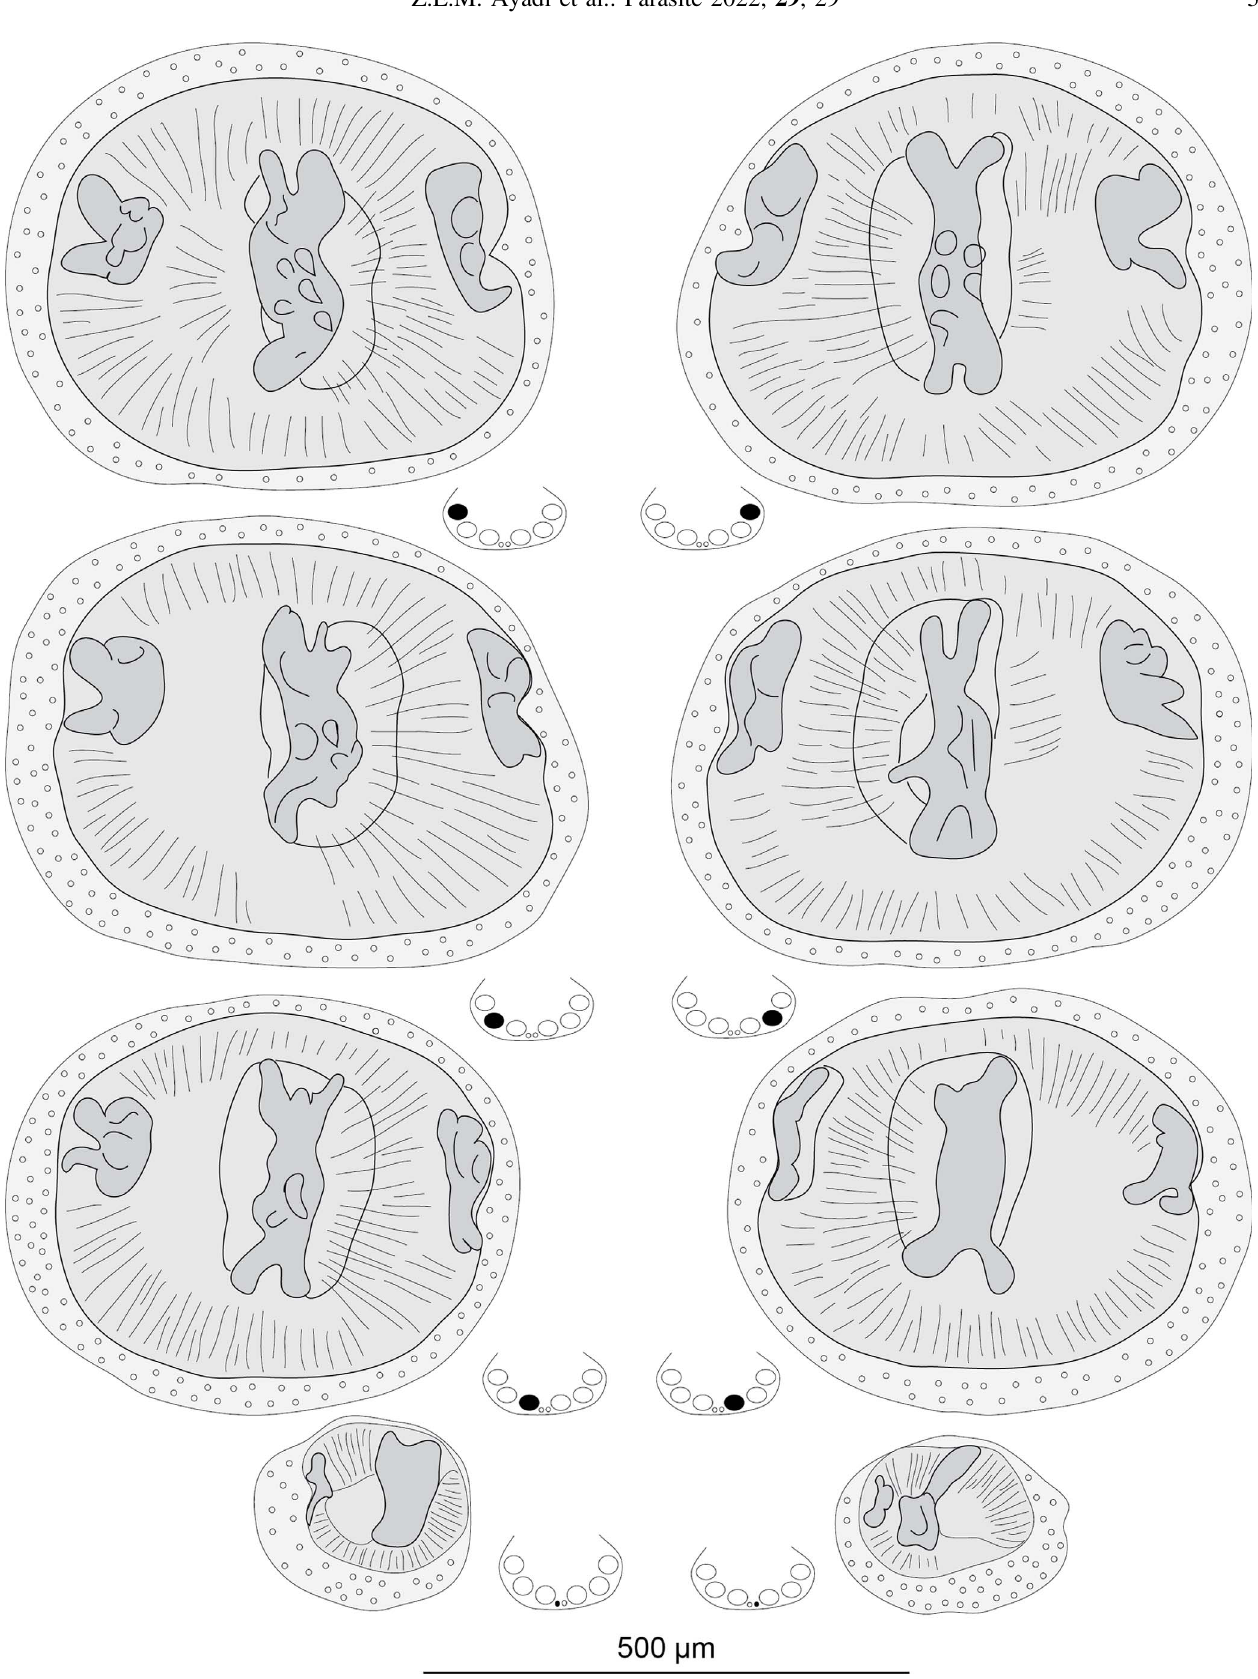
Figure 2. All clamps of a specimen of Hexostoma thynni . The sketches indicate the position of each clamp. Slide MNHN